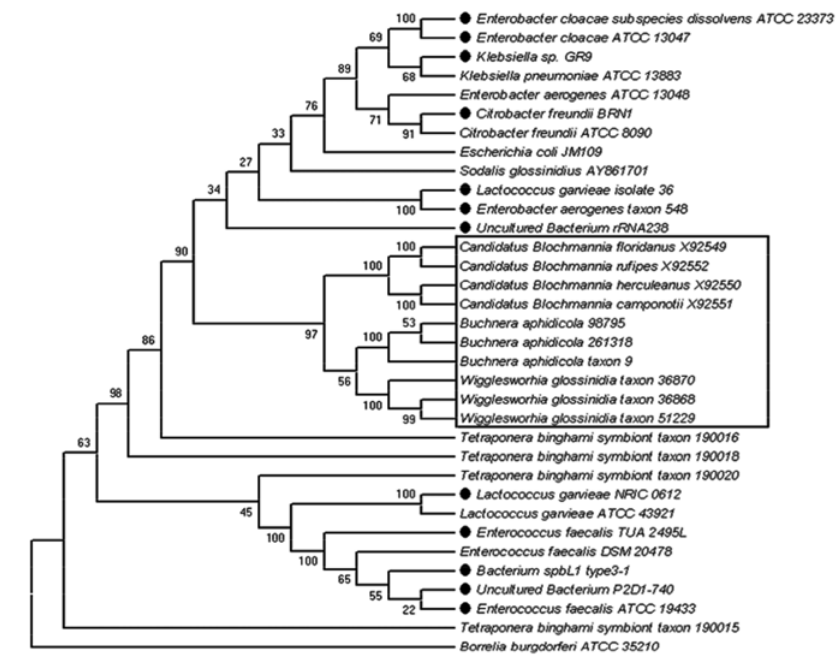
Fig. 2. Phylogenetic affiliation of the bacteria found in the Bogalusa colony after 82 days. after 82 days. Dotted species represent bacteria found in the lab-reared colony. All other entries are type strains or endosymbionts found in other